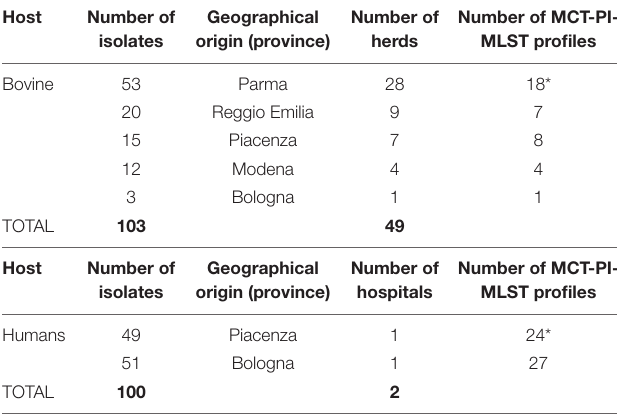
TABLE 1 | Origin and characteristics of Streptococcus agalactiae isolates included in this study.